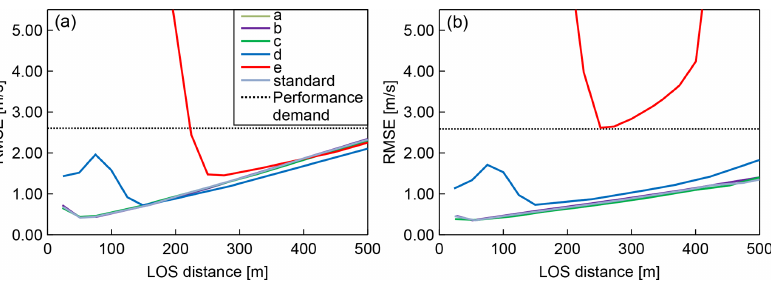
Figure 20. Statistical estimation performance (root mean square error) for LOS wind velocities (including error and noise) under six atmospheric-condition scenarios (a–e and standard) with numerical weather prediction data. (a) Simple vector conversion; (b) proposed